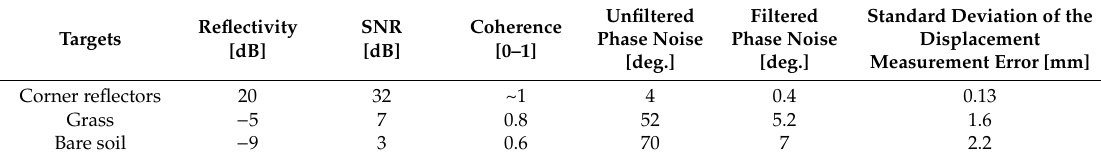
Table 5. DInSAR parameters calculated considering the reflectivity and signal-to-noise ratio (SNR) of the corner reflector and the grass